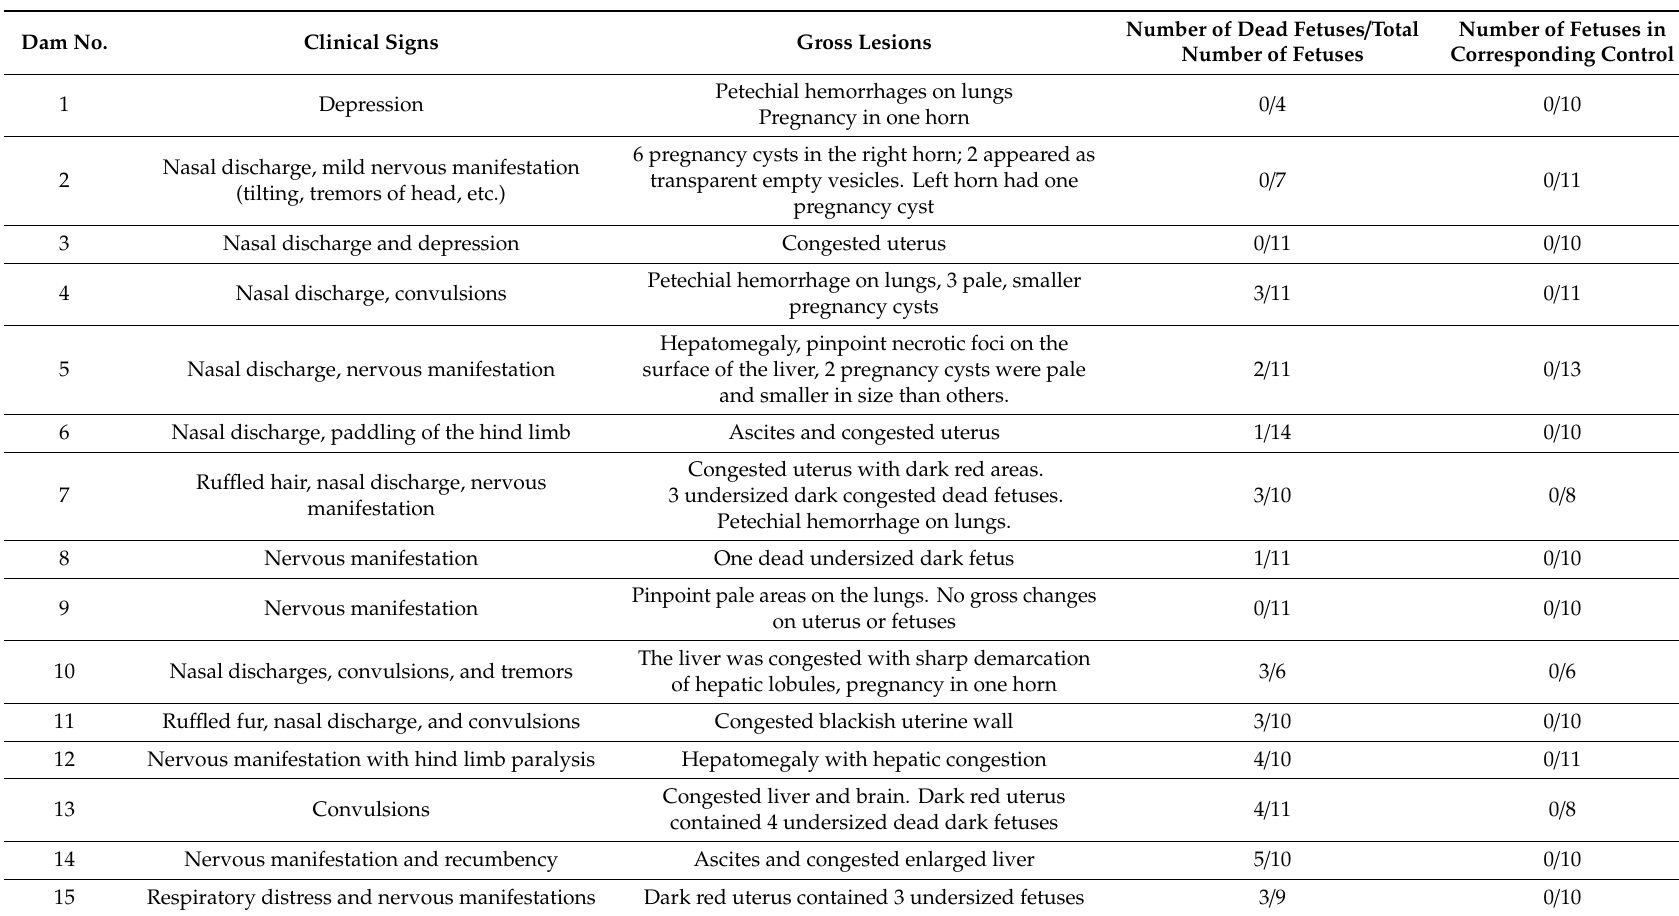
Table 2. Clinical signs, gross lesions, and the number of dead fetuses in hamster dams inoculated intranasally with EHV-9. Dam